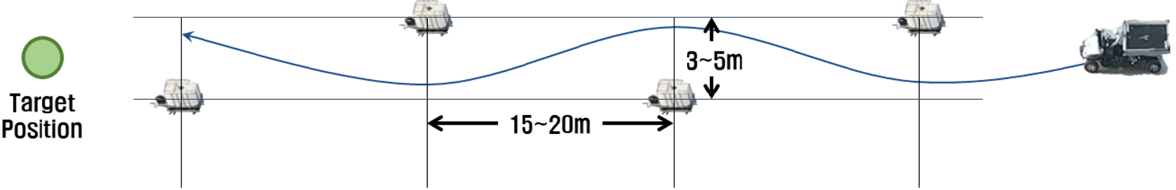
Figure 11. Avoiding multiple obstacles. ( a ) ( b ) Figure 12. Driving test among o bstacles. ( a ) Path of UGV and point cloud data during autonomous driving. ( b ) Steering and speed of UGV.